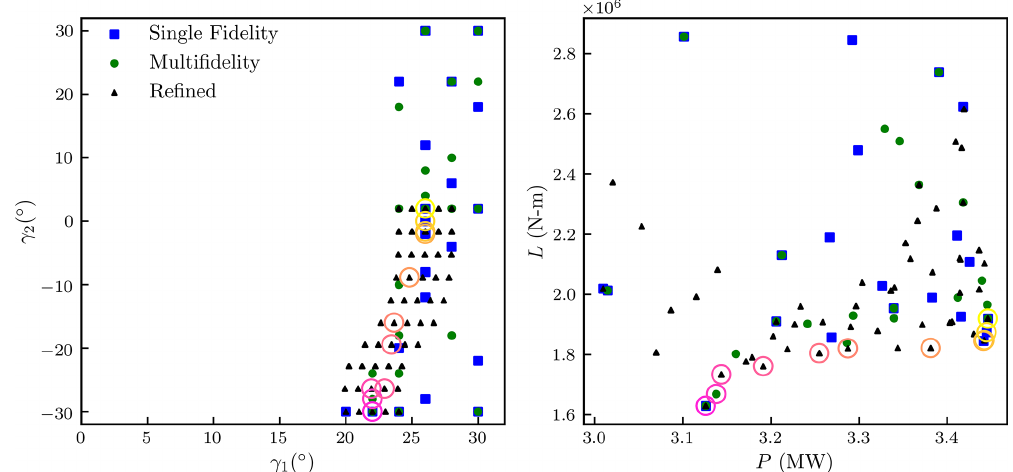
Figure 5. Sampled inputs and outputs associated with power greater than 3MW and loads less than 3MNm. Points associated with the single-fidelity approach are shown using blue square markers, and points associated with the multifidelity approach are shown using green circular markers. Refinement points are shown as black triangles. A Pareto set constructed from the single-fidelity, multifidelity, and refine- ment samples is highlighted with hollow circles, where darker (magenta) circles correspond to Pareto points with lower loads and lower powers. Table 2. Observed power and loads for various yaw configurations. γ 1 γ 2 Power Load Front turbine Back turbine Front turbine Back turbine ( ◦ ) ( ◦ ) (MW) (M-Nm) Power (MW) Power (MW) DEL (M-Nm) DEL (M-Nm) 30